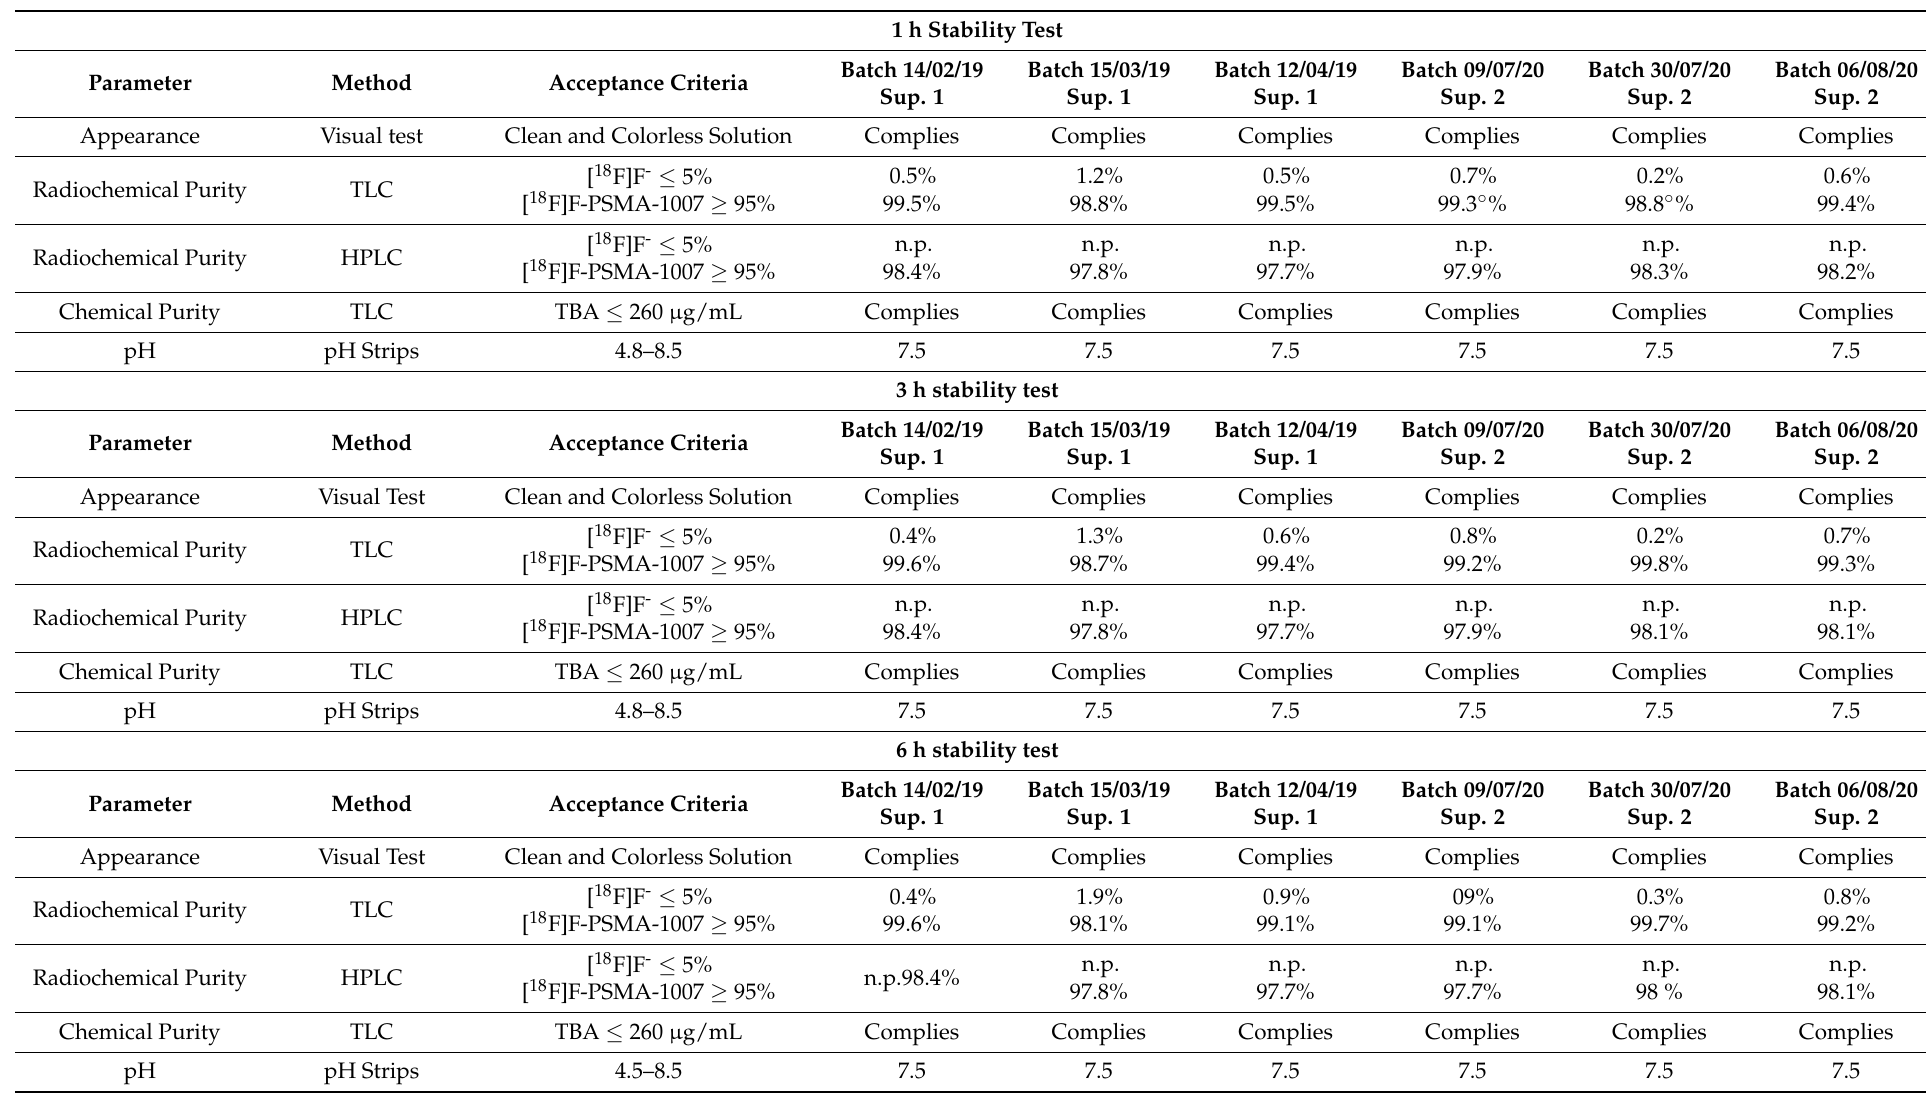
Table 6. Stability test of injectable solution of [ 18